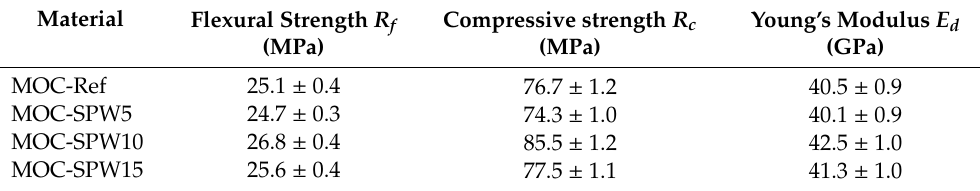
Figure 2. Di ff raction patterns of MOC-REF, MOC-SPW5, MOC-SPW10 and MOC-SPW15. Figure 2. Diffraction patterns of MOC-REF, MOC-SPW5, MOC-SPW10 and MOC-SPW15. Table 5. Mechanical parameters of MOC Table 5. Mechanical parameters of MOC composites.